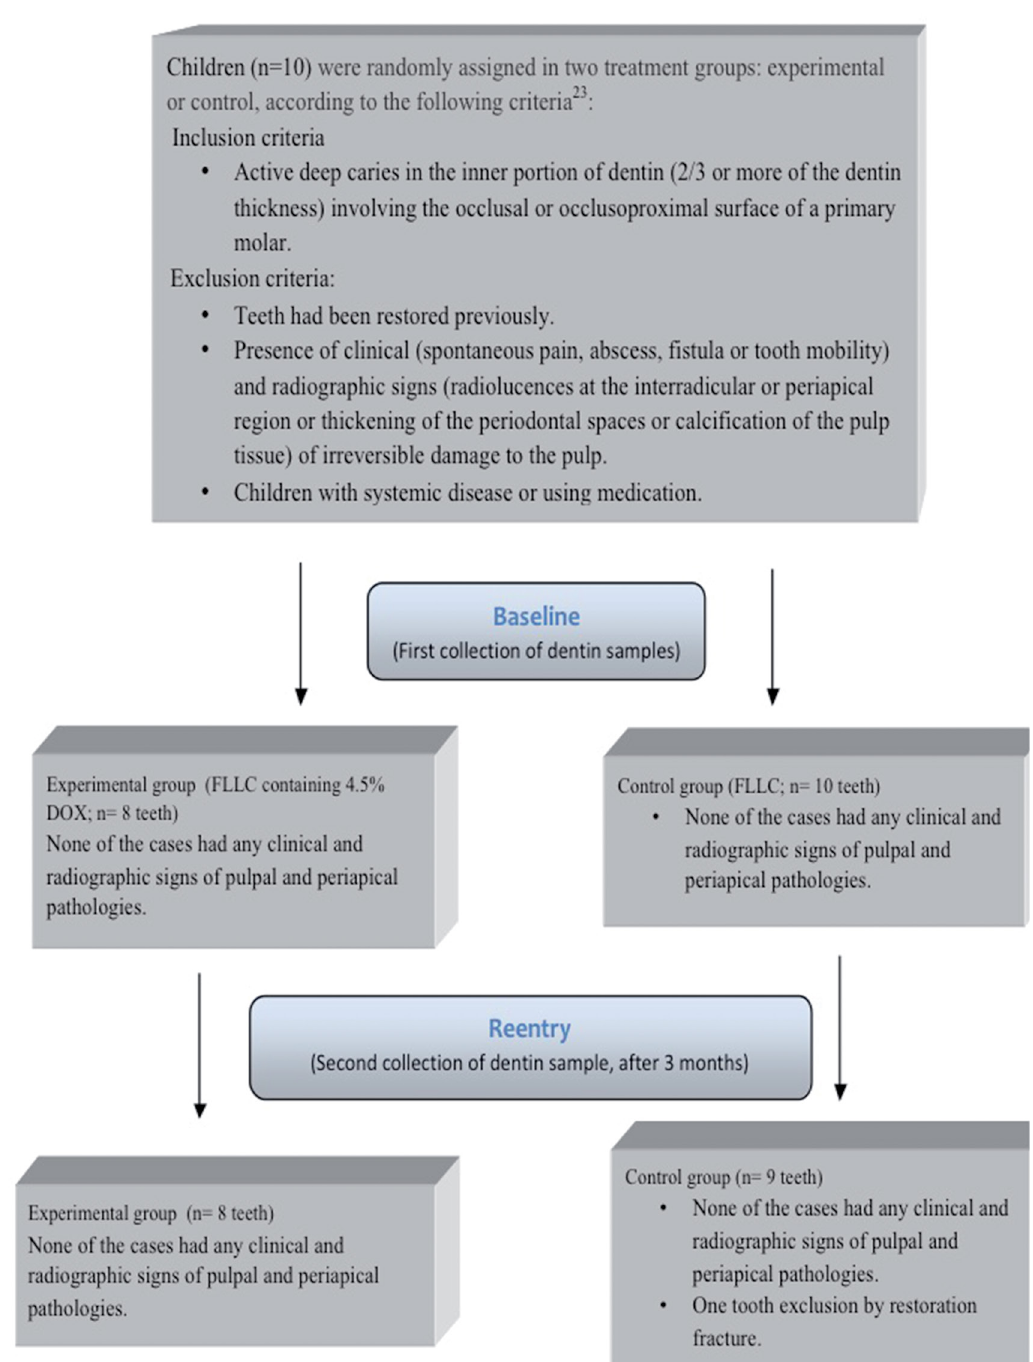
Figure 1- Flow diagram detailing child recruitment, treatment, and follow-up (3 months) of the